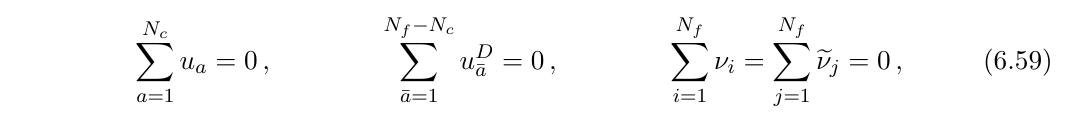
and u D c (cid:22) a